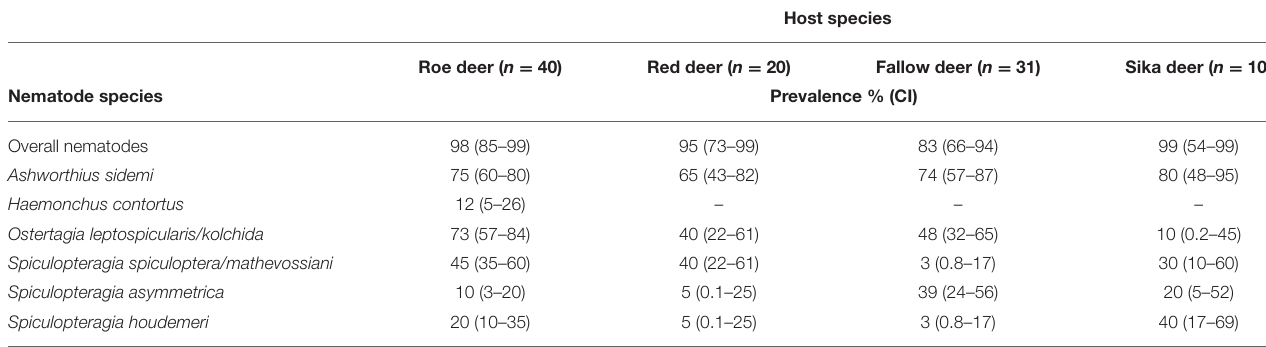
TABLE 1 | Prevalence of abomasal nematodes in the main cervids culled between 2016 and 2019. Moose (single case) and white-tailed deer ( n = 2) are not included in the table due to the low number of individuals examined. Host species Roe deer ( n =